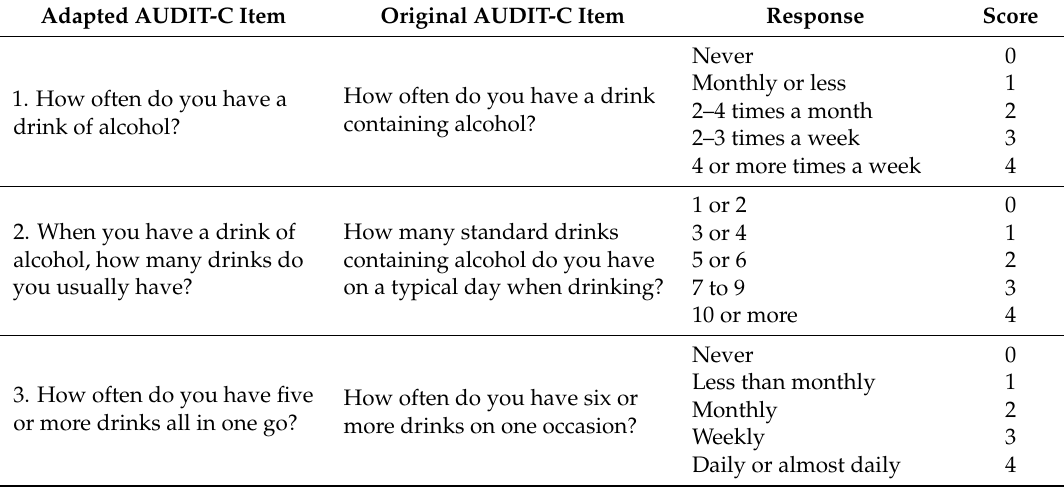
Table 1. AUDIT-C—adapted wording for Indigenous